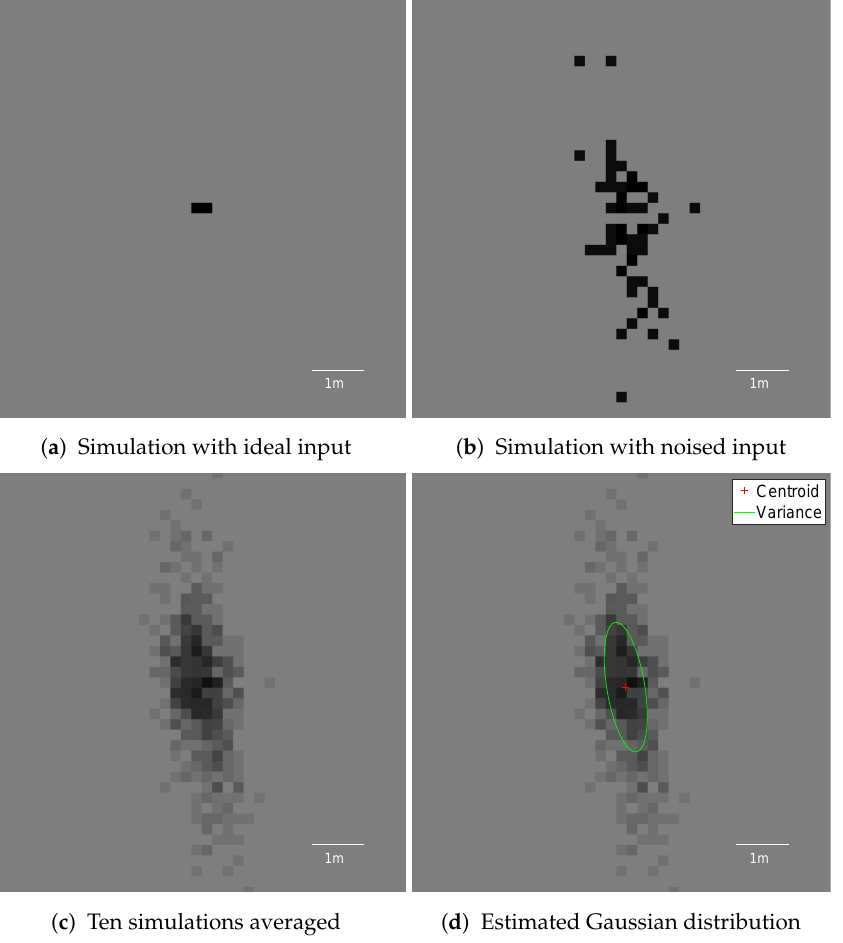
Figure 7. Occupancy grid representations of the pole using a simple hit point sensor model with disabled filtering methods. Each snapshot presents the pole located laterally 10 m to the right side of the vehicle, captured when the host was 10 m longitudinally from the